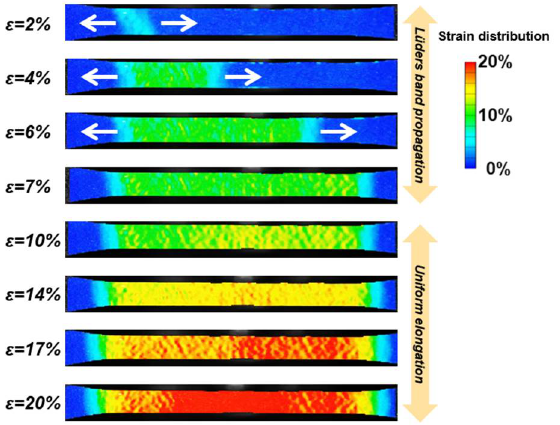
Figure 3. Evolution of strain distribution along the gauge section of the 1.5Cu1.5Ni-WR specimen during tensile deformation at different engineering strain ( ε ) levels.